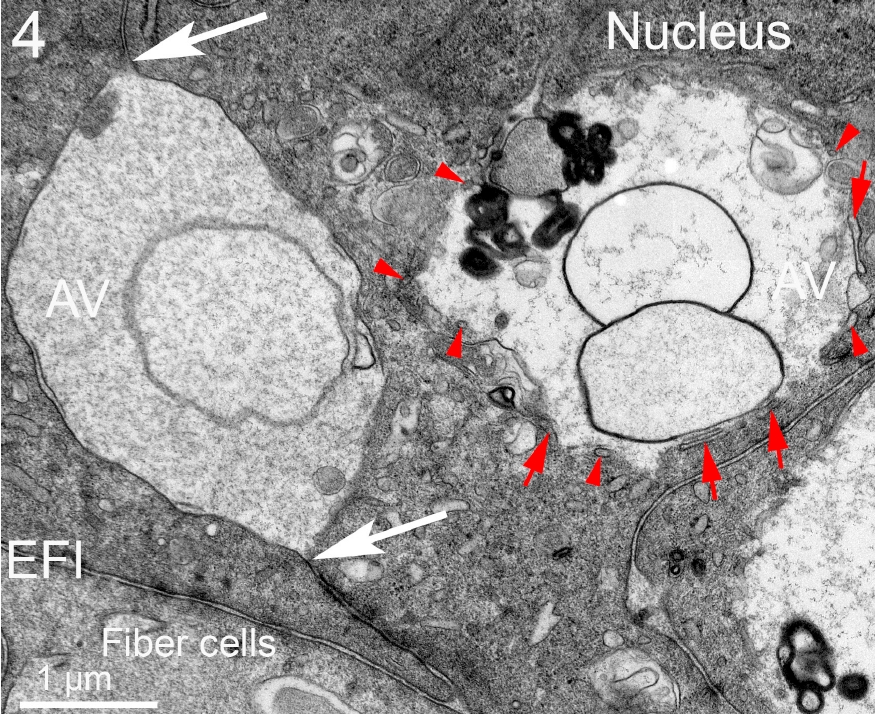
Figure 4. Extensive autophagic activity in the equatorial epithelium of prosimian Galago (bush baby) monkey lenses. A large autophagosome (AV) is observed in contact with a nucleus (upper right), which probably signals the supply of new ER membrane for expansion. The double-membrane surface is modified to present interconnected tubules with two membranes visible (red arrows) and cross-sections that are round or oval (red arrowheads). These membrane processes form an open meshwork that surrounds the autophagic vesicle, allowing hydrolytic enzymes to enter and degradation products to exit, including here from the degradation of proteins, large vesicles, and pure lipid aggregates (densely stained clusters with 5 nm spacing visible at higher magnification). This is an example of a classic autophagic vesicle. By contrast, the large autophagic vesicle on